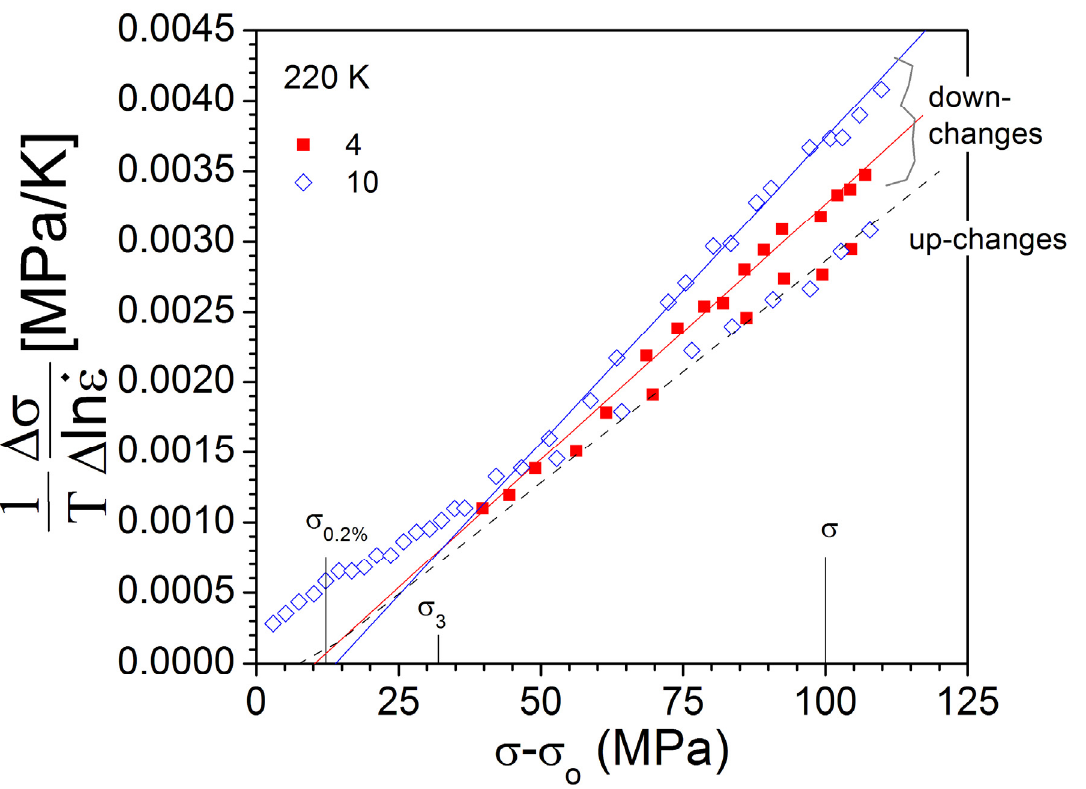
Figure 13. Haasen plot of sealed-GB specimen tested at 220 K where up- and down-rate changes are shown for factors of 4 and 10. Due to the clear separation of the yield phenomenon from the higher strain region, the separation of the debris contribution from that of the forest can be performed.